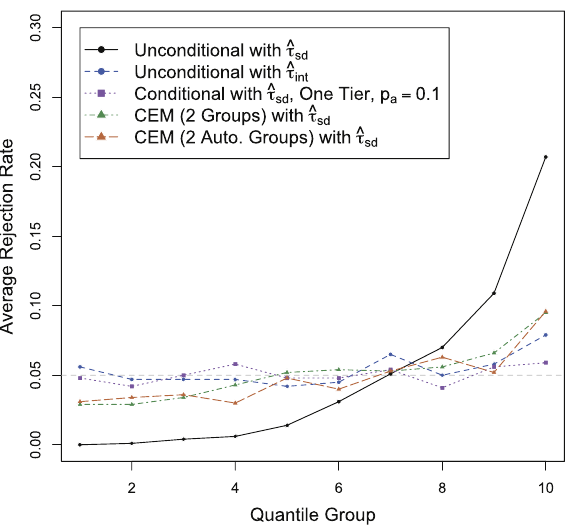
Figure 8: The rejection rate of the five randomization tests when Fisher’s Sharp Null Hypothesis is true (i.e., τ = 0) and β = 3 for the unbalanced design scenario. Rejec- tion rates are shown within each quantile group of the Mahalanobis distance, such that each quantile group cor- responds to 1,000